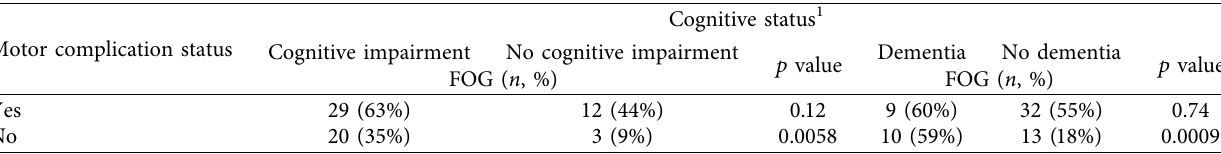
Table 5: Association of cognitive status with freezing of gait in subjects with and without motor complications.